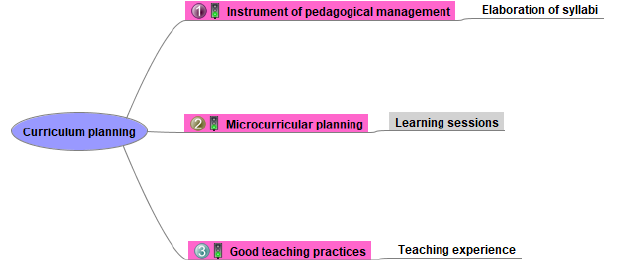
Fig. 3. Curriculum